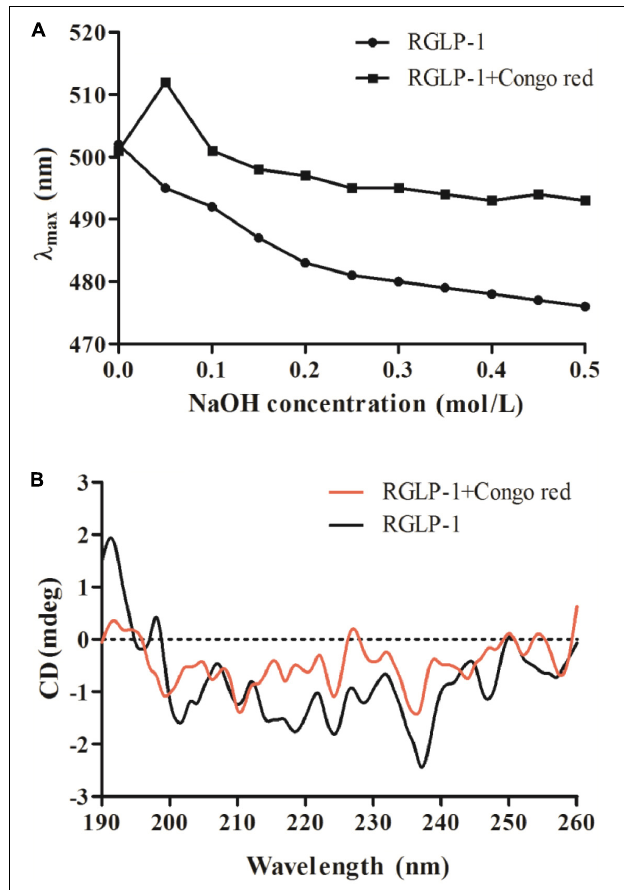
FIGURE 6 | Maximum absorption wavelength of RGLP-1 and RGLP-1 + Congo red at different concentrations of NaOH (A) ; CD spectrogram (B) of